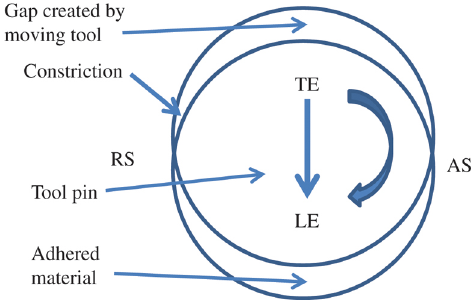
Figure 13: Showing the tool pin and the constriction at the RS of the tool pin. The threaded tool performs two functions, one is the pushing of the material downwards and the other is effectively breaking the interface of the two butt plates and plastically deforming the interface, which may not be properly achieved by an unthreaded tool pin. At higher rpms, both functions will be performed to a higher degree by the tool pin; but at lower rpms (such as 300 rpm here) the former function of the pin is of a lesser extent than the latter function. Also, materials at the front side of the moving tool, as they are, are transferred to the backside of the tool. This is possible if and only if there is no mixing within the materials and if there is no considerable top down and bottom up movement of the material in the weld volume, especially at regions slightly away from the tool pin. So one can conclude that, at lower rpms, the transfer of material occurs in almost horizontal layers, parallel to top and bottom surfaces of the plates. This is justified in Figure 4 where the material transfer and deposition is uniform, consecutive and systematic in horizontal planes, throughout top to bottom of WN. So at low rpms an almost extrusion type of flow of materials in horizontal layers occurs in the WN. Similar observations had been made by Colligan [10]; see Section 3.1, first paragraph. Colligan ’ s